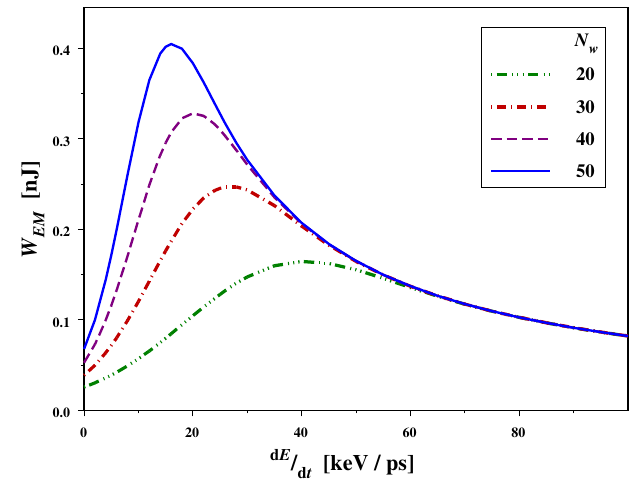
=dt with k (cid:4) 1 : 8 MeV and the k (cid:15) 475 GHz . s